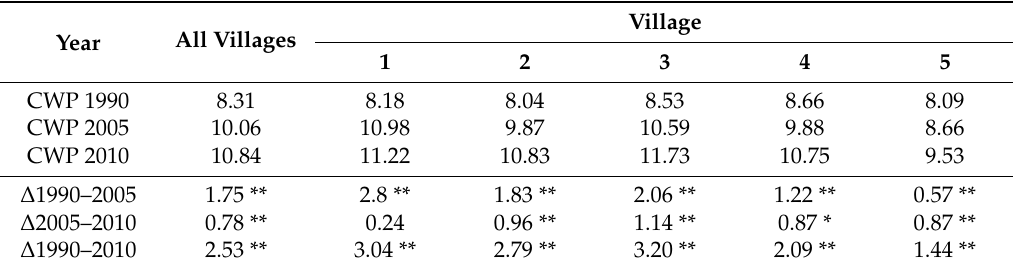
Table 3. CWP of the cropping system by village and change in CWP (indicated by ∆ CWP) during model periods measured in kg ha − 1 mm − 1